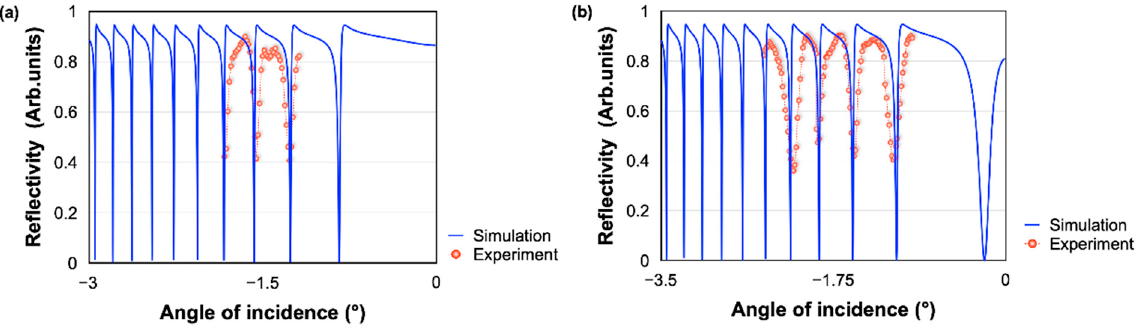
Figure 6. Reflectivity spectra measurement with the SMCW waveguide with ( a ) air and ( b ) water in the sensing cell.